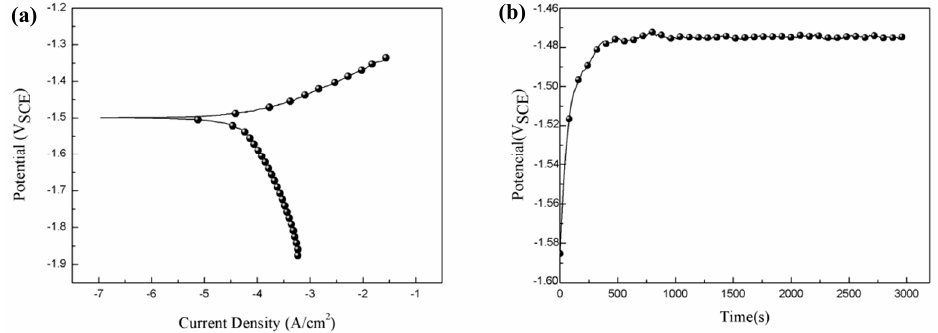
Figure 5. ( a ) The potentiodynamic polarization curve and ( b ) the open circuit potential of the extruded alloy measured in the simulated body fluid (SBF) solution.